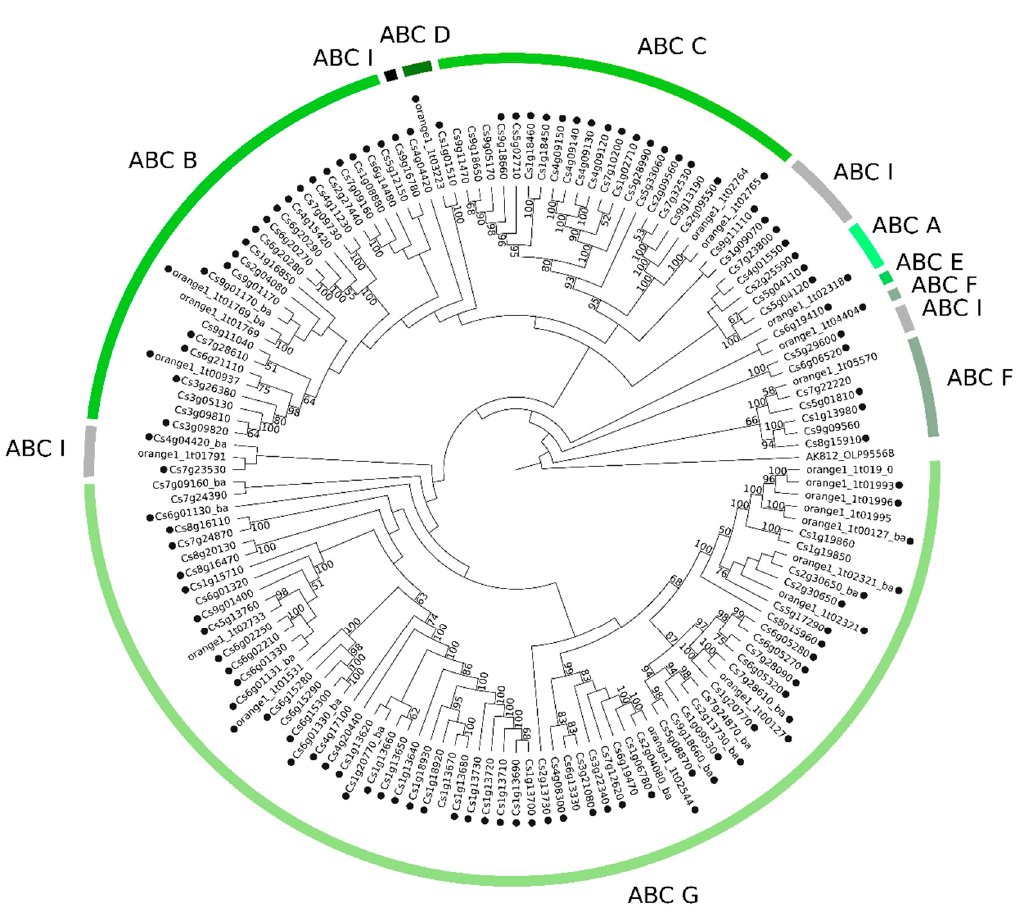
Figure 4. Maximum likelihood tree of 143 ABC amino acid sequences from C. sinensis genome. Numbers above the branches represent bootstrap values. The black circles represent genes that have an associated transcript sequence in the CRT. AK812_OLP95568 was used as outgroup (Symbiodinium microadriaticum str. CCMP2467, gene ABCF3, ATP-binding cassette subfamily F member 3).